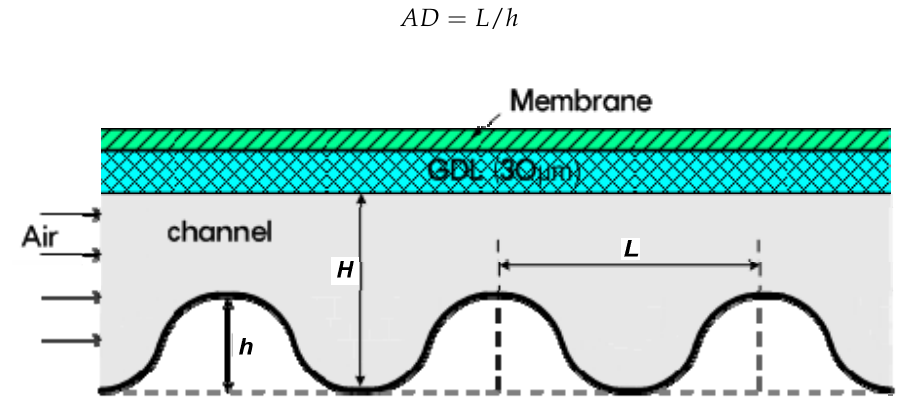
Figure 2. The parameters of a wave form channel.